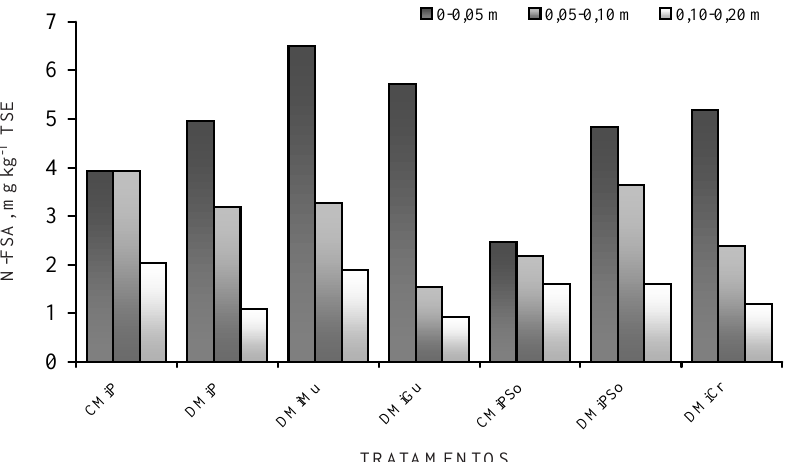
Figura 3. Valores de N total na fração solúvel em água (FSA) da matéria orgânica, em um Latossolo Roxo cultivado com diferentes sistemas de produção por seis anos consecutivos. C = sistema de semeadura convencional; D = sistema de plantio direto; Mi = milho semeado no verão; So = soja semeada no verão; P = pousio no inverno; Mu = semeadura de mucuna-preta no inverno; Gu = semeadura de feijão guandu no inverno; Cr = semeadura de Crotalaria juncea no